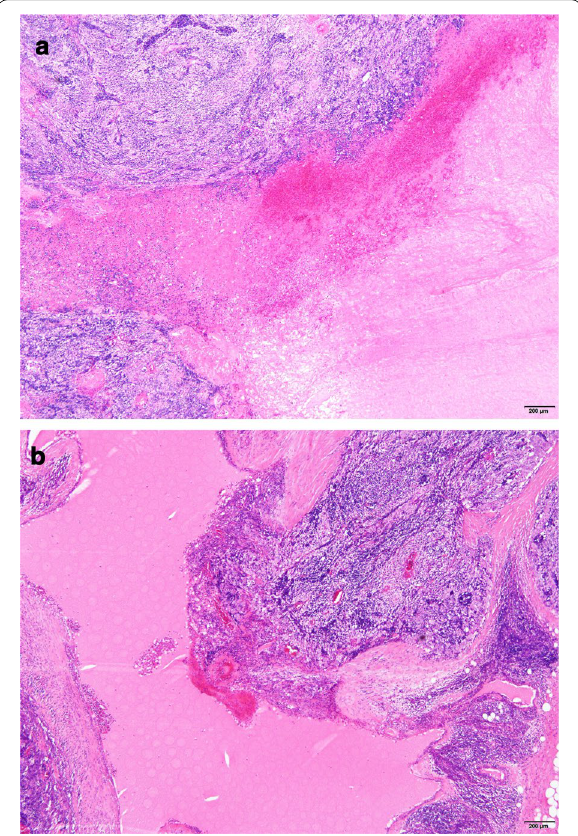
Fig. 2 Microscopic findings showed that the tumor was 59 47 21 mm, and consisted of a solid lesion with a cystic × × component (hematoxylin and eosin, 40). The tumor pathologically × classified as WHO type B2 thymoma. In thymoma, there was an extensive hemorrhagic necrosis which infraction might have resulted in ( a ). There were multilocular thymic cysts combined with thymectomy combined with partial resection of left brachiocephalic vein, left upper lobe and left phrenic nerve (Fig. 1c). The total length of the operation was 246 min, and the amount of blood loss was 160 ml. The patient was discharged 8 days after the operation with no chest pain and no postoperative complications. Microscopically, the operative specimen showed that the tumor was 59 47 21 mm, and consisted of a × × solid lesion with a cystic component. Polygonal atypi- cal cells with eosinophilic cytoplasm and round nuclei were proliferating in sheet form. In the upper part of the tumor, there was an extensive hemorrhagic necro- sis suggesting infarction (Fig. 2a). The tumor had infil- trated partially into the surrounding adipose tissue, but it did not invade the phrenic nerve, left brachiocephalic vein and left lung. Based on these findings, the mass